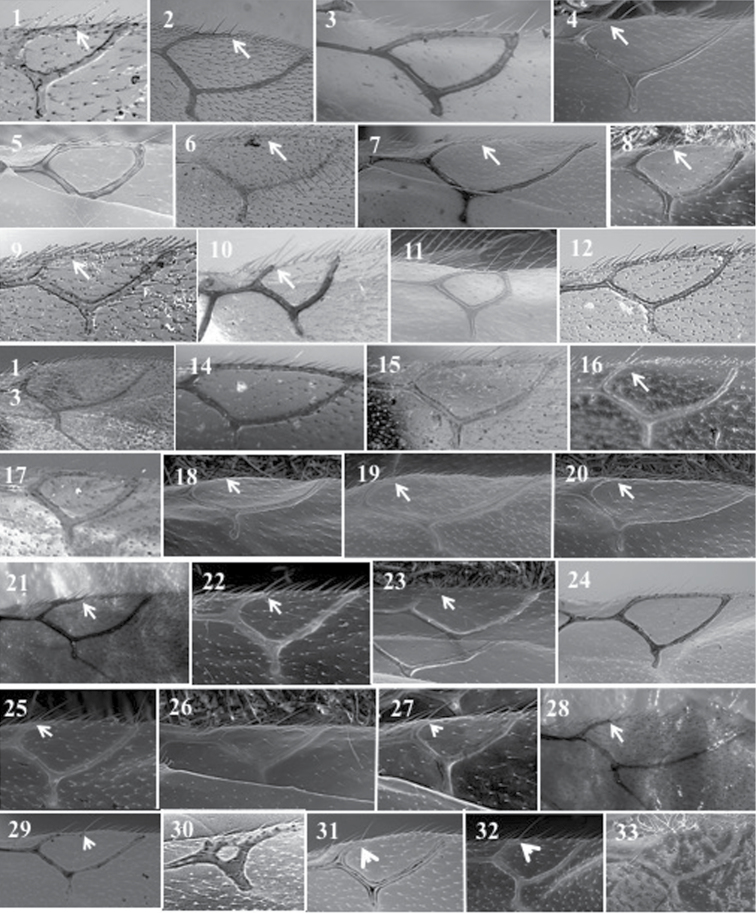
Alloxysta radial cell. A.rufiventris (1); A.salicicola (2); A.sawoniewiczi (3); A.samurai (4); A.sarae (5); A.semiaperta (6); A.sharkey (7); A.slovenica (8); A.soluta (9); A.thorpei (10); A.torresi (11); A.tscheki (12); A.vandenboschi (13); A.victrix (14); A.xanthocera (15); A.xanthopa (16); A.xanthopsis (17); A.centroamericana (18); A.alpina (19); A.areeluckator (20); A.buffingtoni (21); A.franca (22); A.huberi (23); A.neartica (24); A.pili (25); A.petchabunensis (26); A.texanae (27); A.vicenti (28); A.viellae (29); A.curta (30); A.palearctica (31); A.pascuali (32); A.nottoni (33).